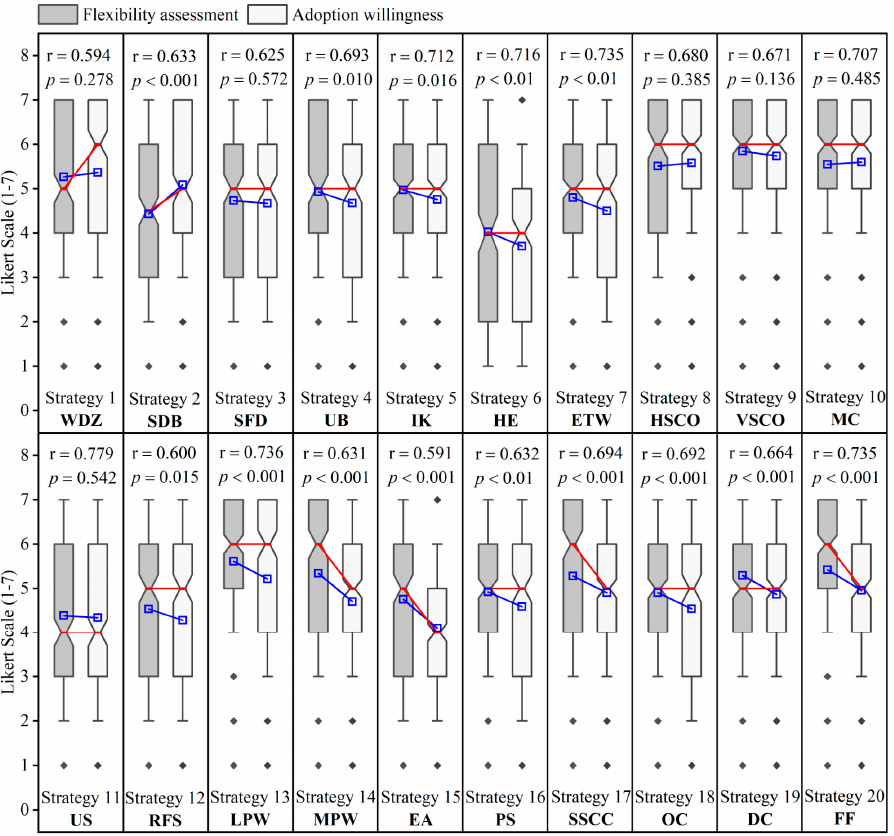
Figure 6. Distribution scores of 2 aspects of the 20 strategies (The red line indicates the median value and the blue line indicates the mean value).